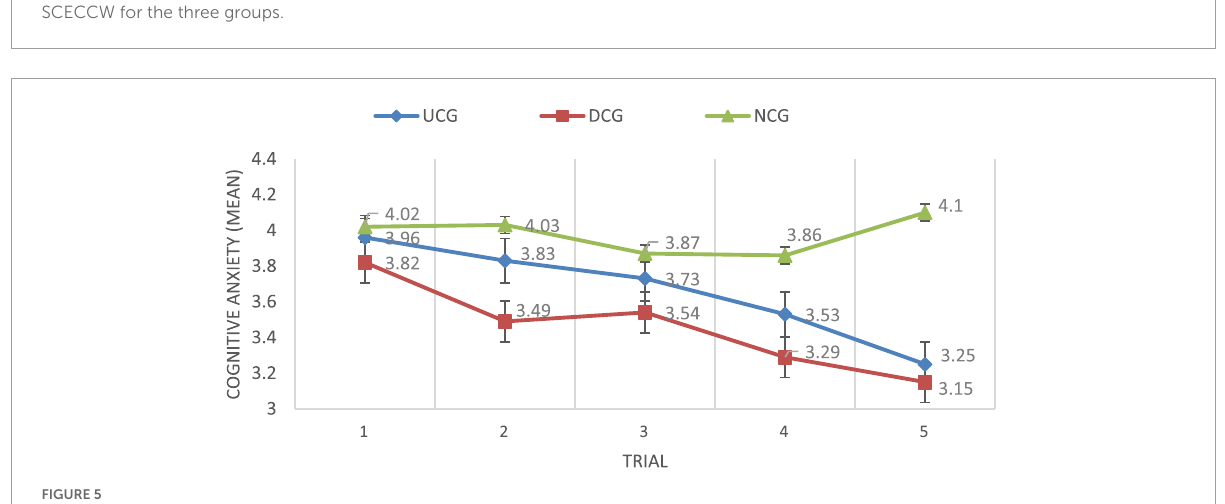
FIGURE4 SCECCW for the three groups.